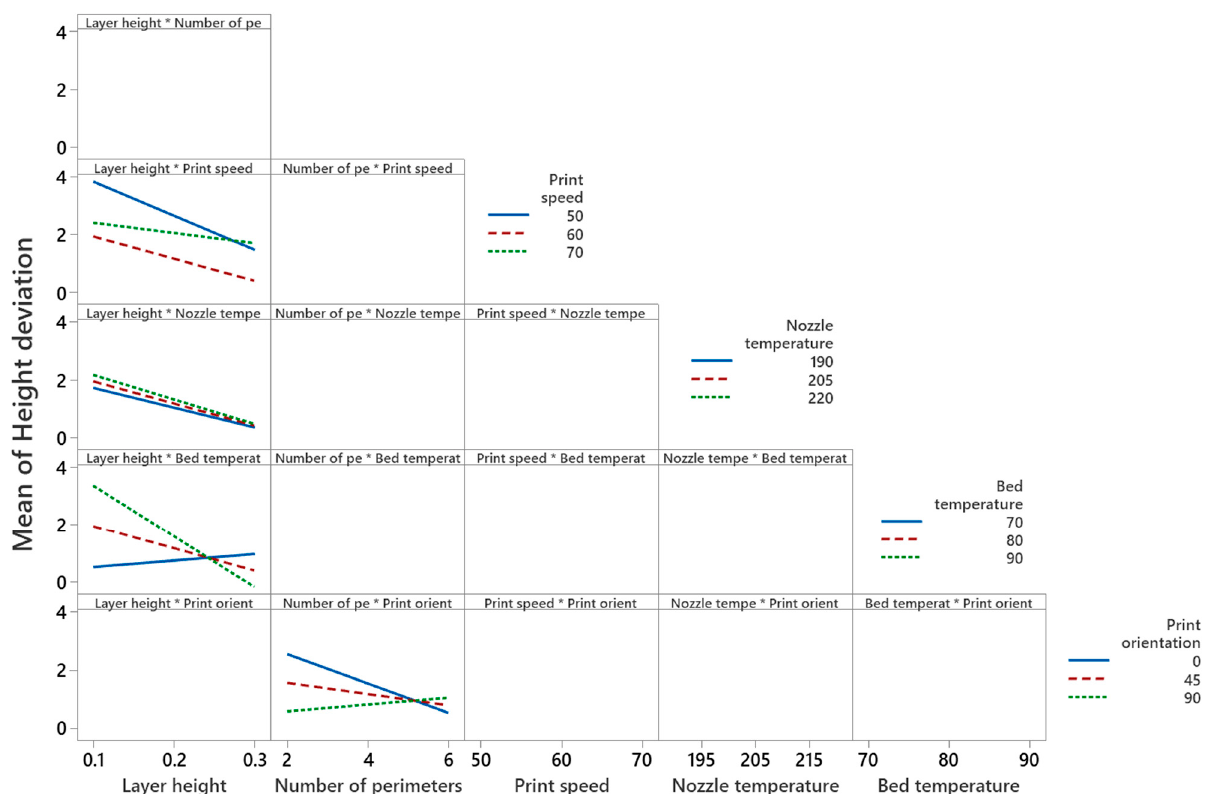
Figure 12. Interaction plot for height